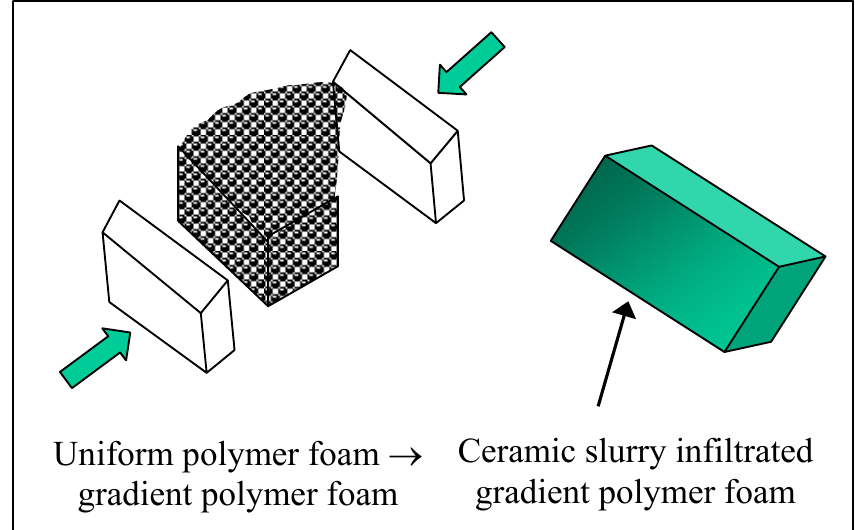
Figure 8. Schematic illustration showing the compression-moulding process for obtaining a gradient sponge